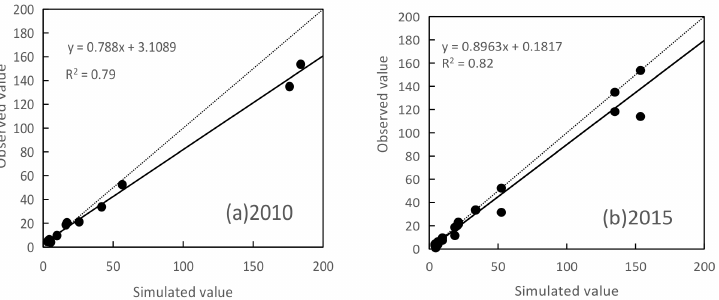
Figure 7. Correlation analysis between simulated value (10 5 t) and observed value (10 5 t) in ( a ) 2010 and ( b )